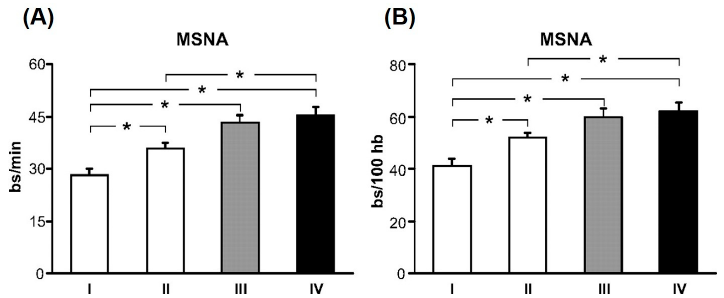
Figure 2. Muscle sympathetic nerve activity (MSNA) expressed as burst frequency (bursts (bs)/min, A) and burst incidence (bs/100 heartbeats (hb), B) in subjects grouped according to their estimated glomerular filtration rate (eGFR), with the highest quartile of eGFR in group I and lowest quartile of eGFR in group IV. With decreasing eGFR, there is a significant and progressive increase in resting MSNA in chronic kidney disease (CKD) patients. * p < 0.05 significant difference between quartiles. (From Grassi et al. [13] with permission).